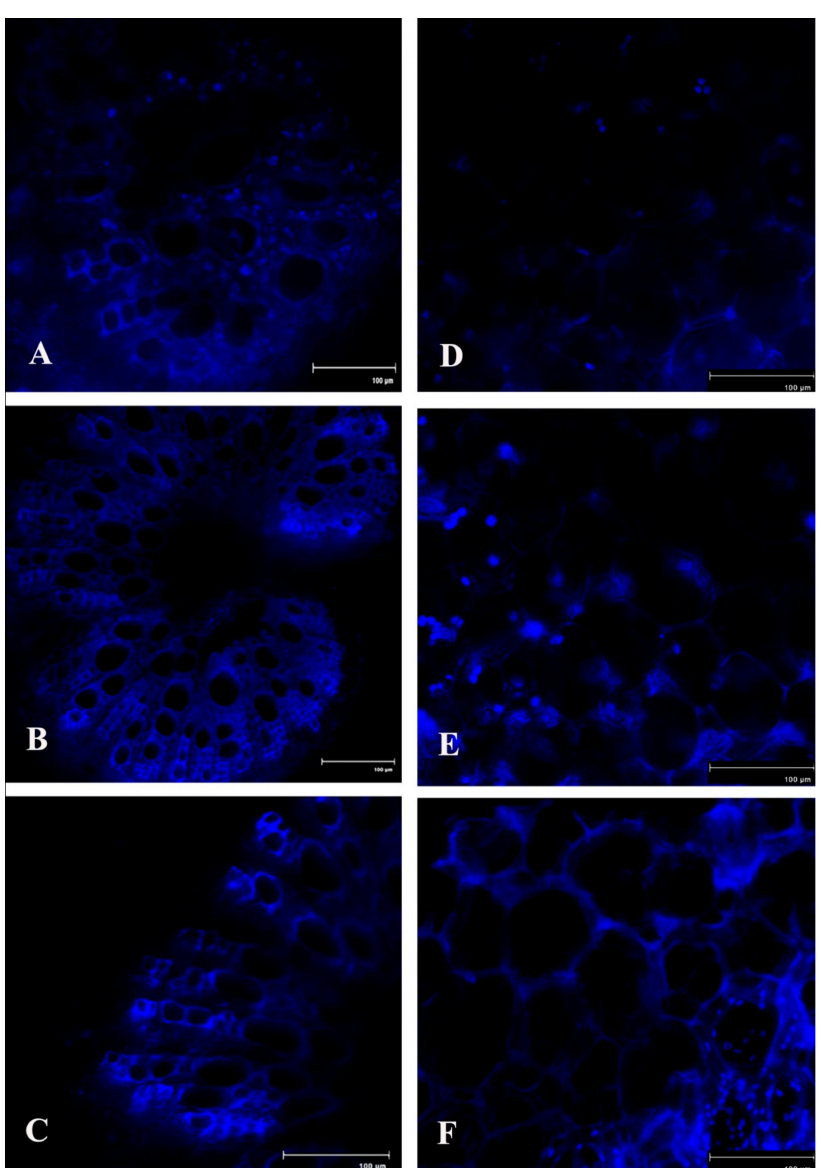
Figure 12. E ff ects of C. gloeosporioides on production of lignin in detached bean leaf petiole (stele and cortex regions). Real-time callose formation was detected by auto-fluorescence in the petiole section: ( A ) 0 dai; ( B ) 2 dai; ( C ) 4